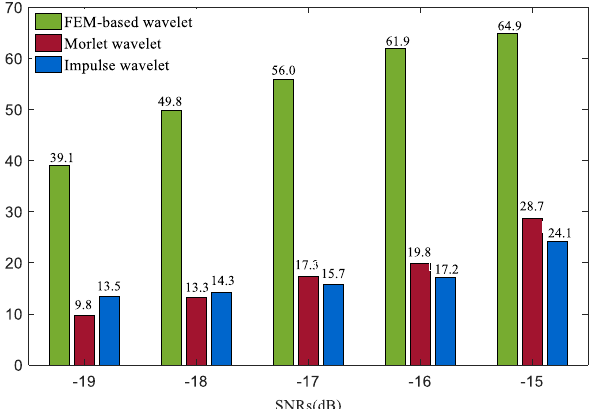
Figure 21. The RoAs of filtered signals of outer ring fault with three wavelet bases at different SNRs.